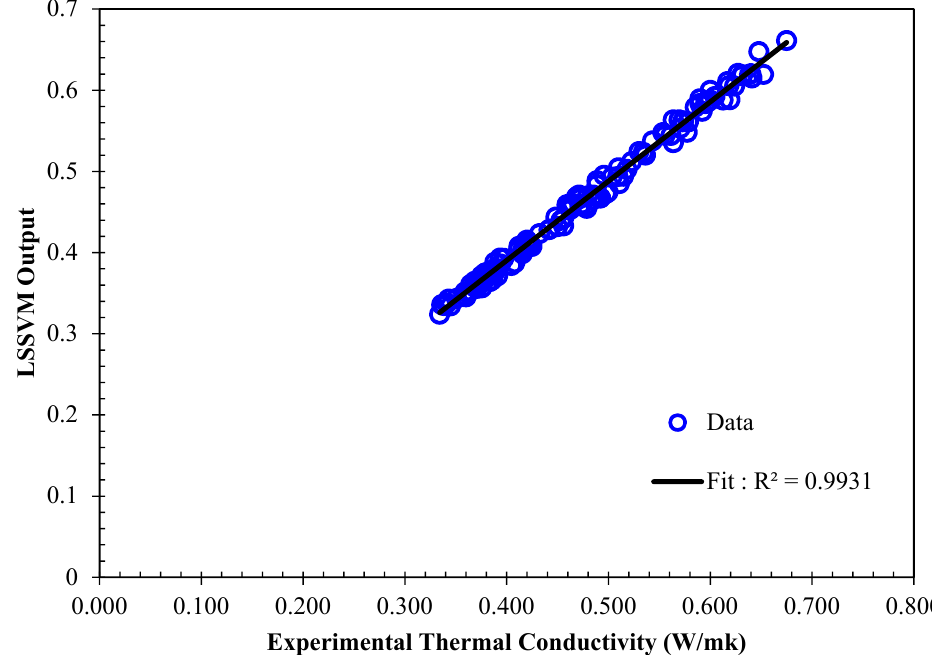
Figure 15. Regression plot of the proposed vector machine model versus actual thermal conductivity of Fe 2 O 3 /ethylene glycol-water nanofluid. Table 5. Statistical parameters of the evolved LSSVM approach for calculating thermal conductivity of (cid:1832)(cid:1857) (cid:2870) (cid:1841) (cid:2871) /ethylene glycol ‐ water nanofluid.